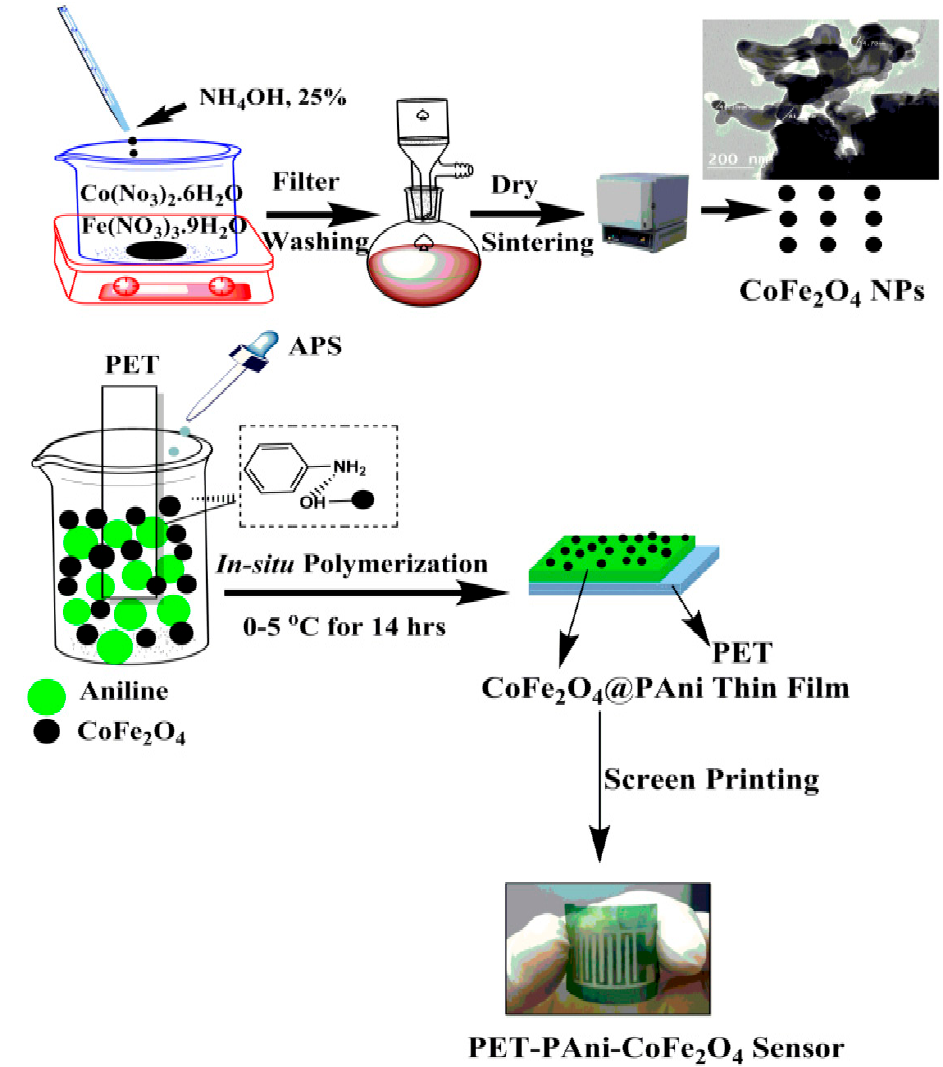
Figure 1. Flexible PET-PAni-CoFe 2 O 4 nanocomposite film formation.